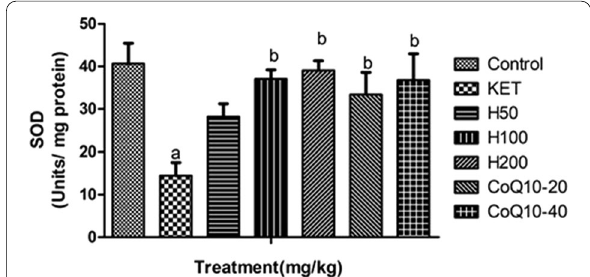
Fig. 13 Effect of hesperidin and Coenzyme Q10 on complex II enzyme activity in the prefrontal cortex region of the brain. Data were analyzed by one-way ANOVA followed by Tukey’s post hoc analysis. All values were expressed as Mean SEM. a p < 0.05 as compared ± to naive, b p < 0.05 as compared to ketamine. KET, Ketamine; H, Hesperidin; CoQ10, Coenzyme Q10